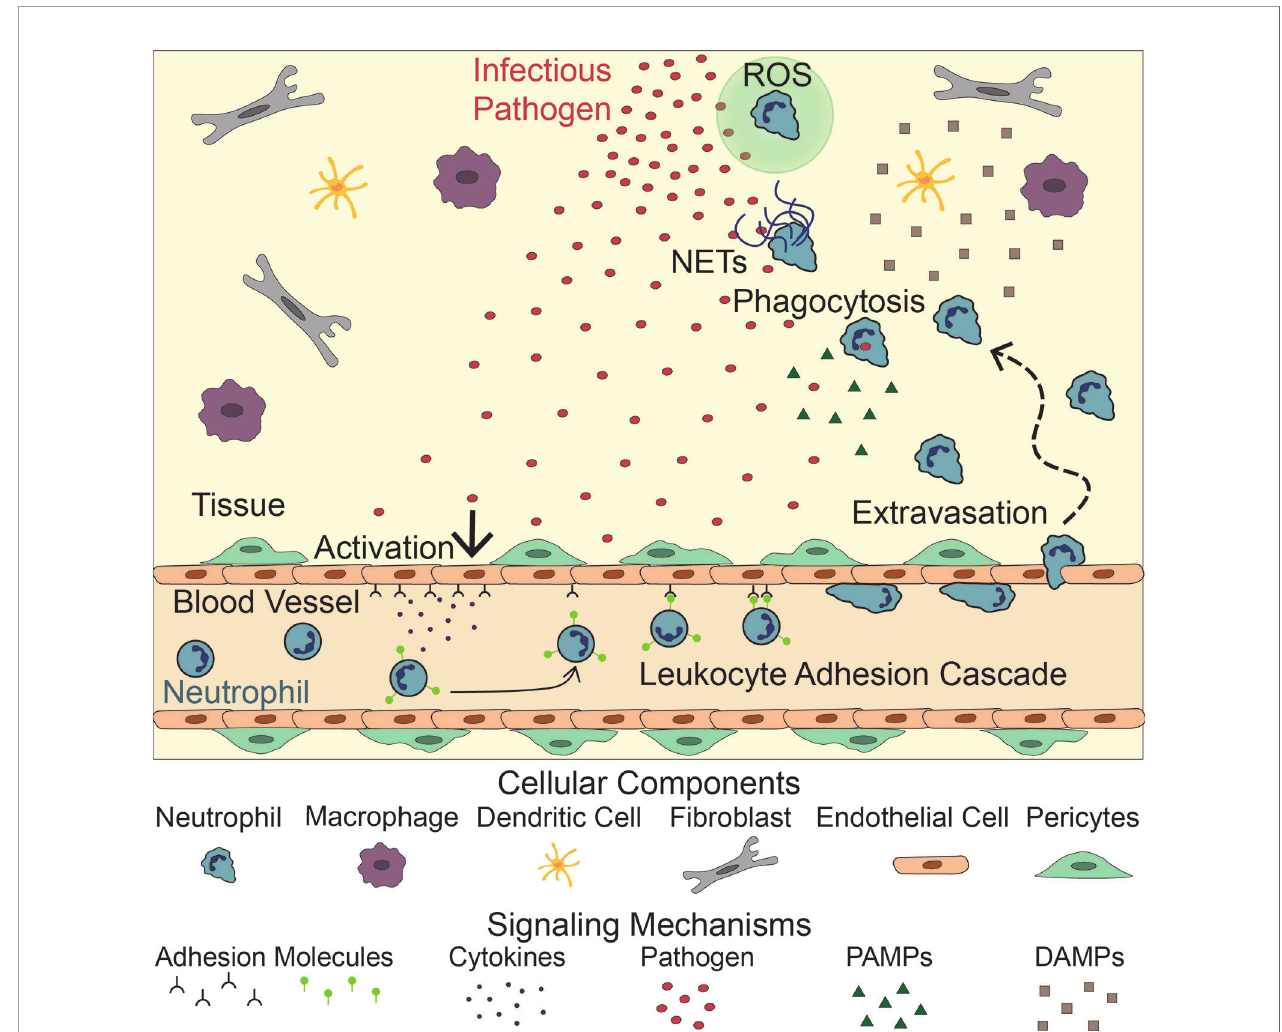
FIGURE 1 | Neutrophil Response to Infection. Following infection, endothelial cells lining the vasculature become activated, releasing adhesion molecules and cytokines. These signals activate neutrophils, initiating the leukocyte adhesion cascade. Neutrophils then extravasate through the blood vessel and migrate to the site of infection following PAMPs, released by the pathogen, and DAMPs released by tissue resident cells (macrophages, dendritic cells, fi broblasts). There, they fi ght the infection by releasing NETs and Reactive Oxygen Species (ROS), and directly phagocytosing the